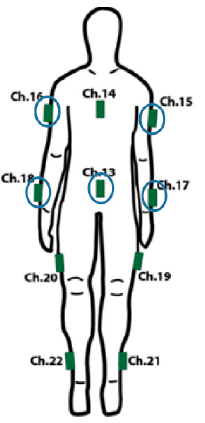
Figure 3. Sensor placements on the body for the motion capture system (green) and the subset of